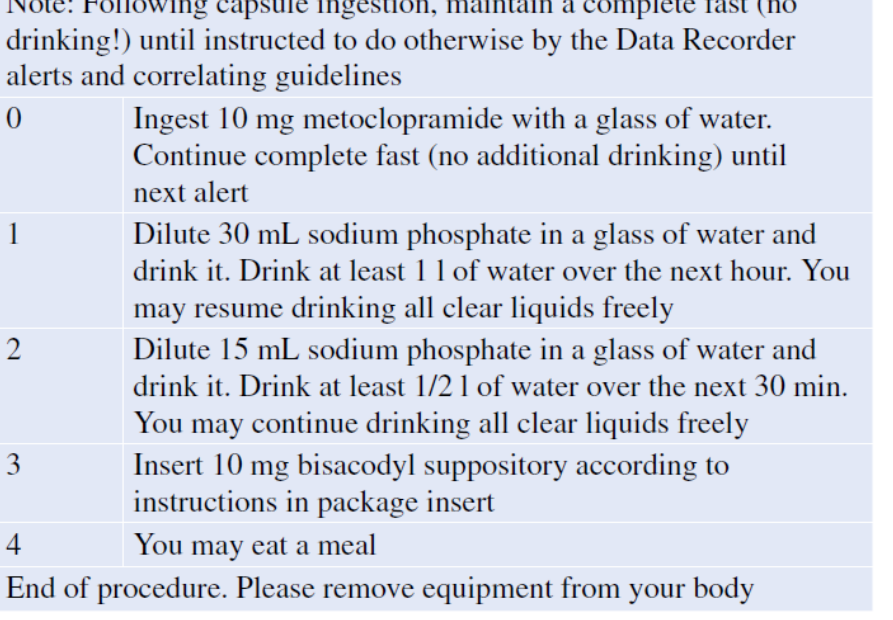
Figure 4. Example for programmable alerts to be shown to the patient triggered by time after capsule ingestion or by automated recognition of small bowel by PillCam Colon 2 or PillCam Crohn’s capsule system.